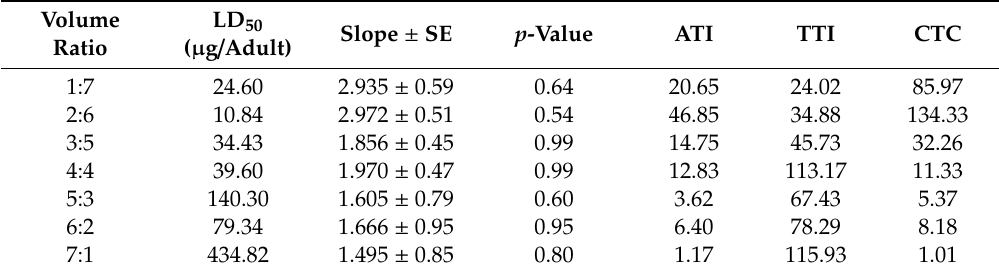
Table 4. Contact toxicity and CTC () of carvone and limonene mixture against T. castaneum adults.